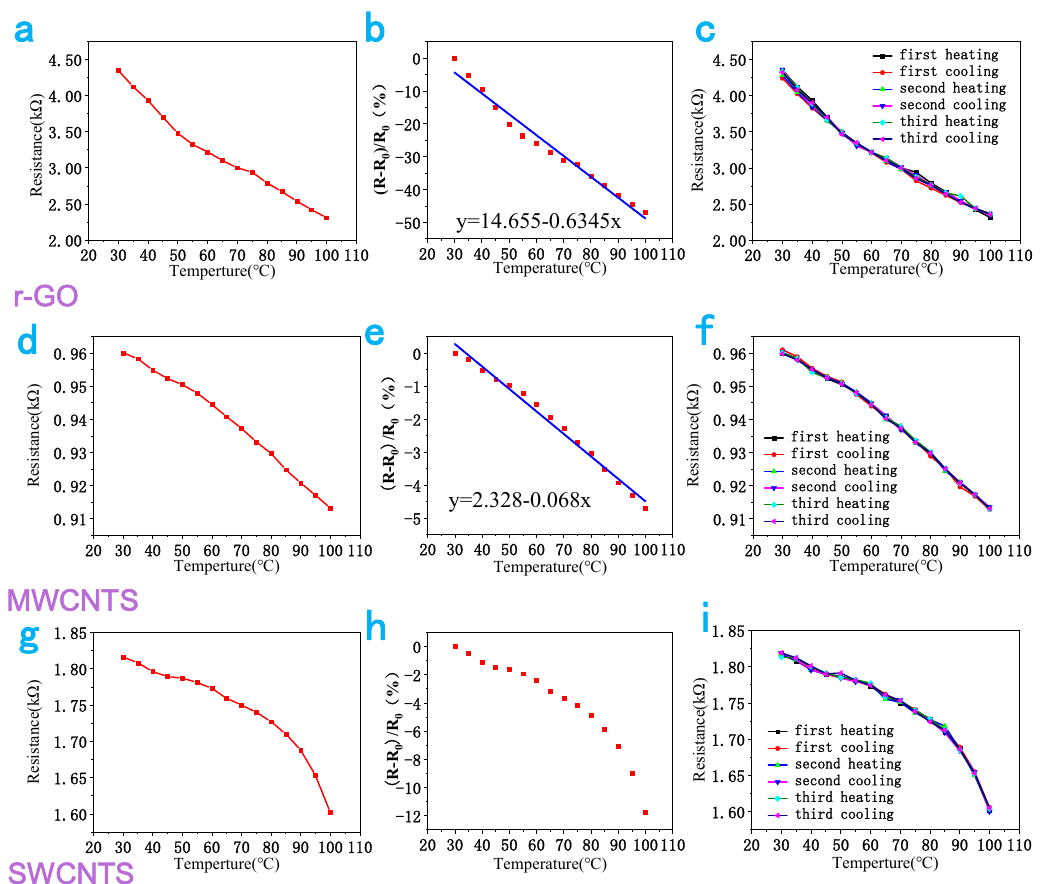
Figure 2. Experimental characterizations of the flexible temperature sensors: ( a , d , g ) the resistance change for r-GO, MWCNTS and SWCNTS respectively; ( b , e , h ) the relative resistance change in the three temperature sensors for temperatures from 30 °C to 100 °C; ( c , f , i ) the resistance responses of these three sensors to three cycles of heating and cooling.